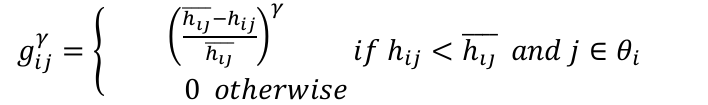
2005 2006 2007 2008 2009 2010 2011 2012 2013 2014 2015 2016 2017